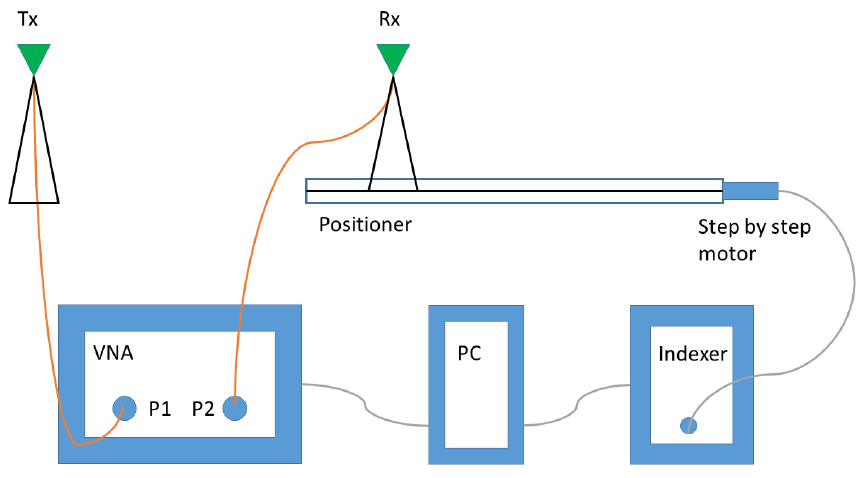
Figure 1. Scheme of the measurement setup.